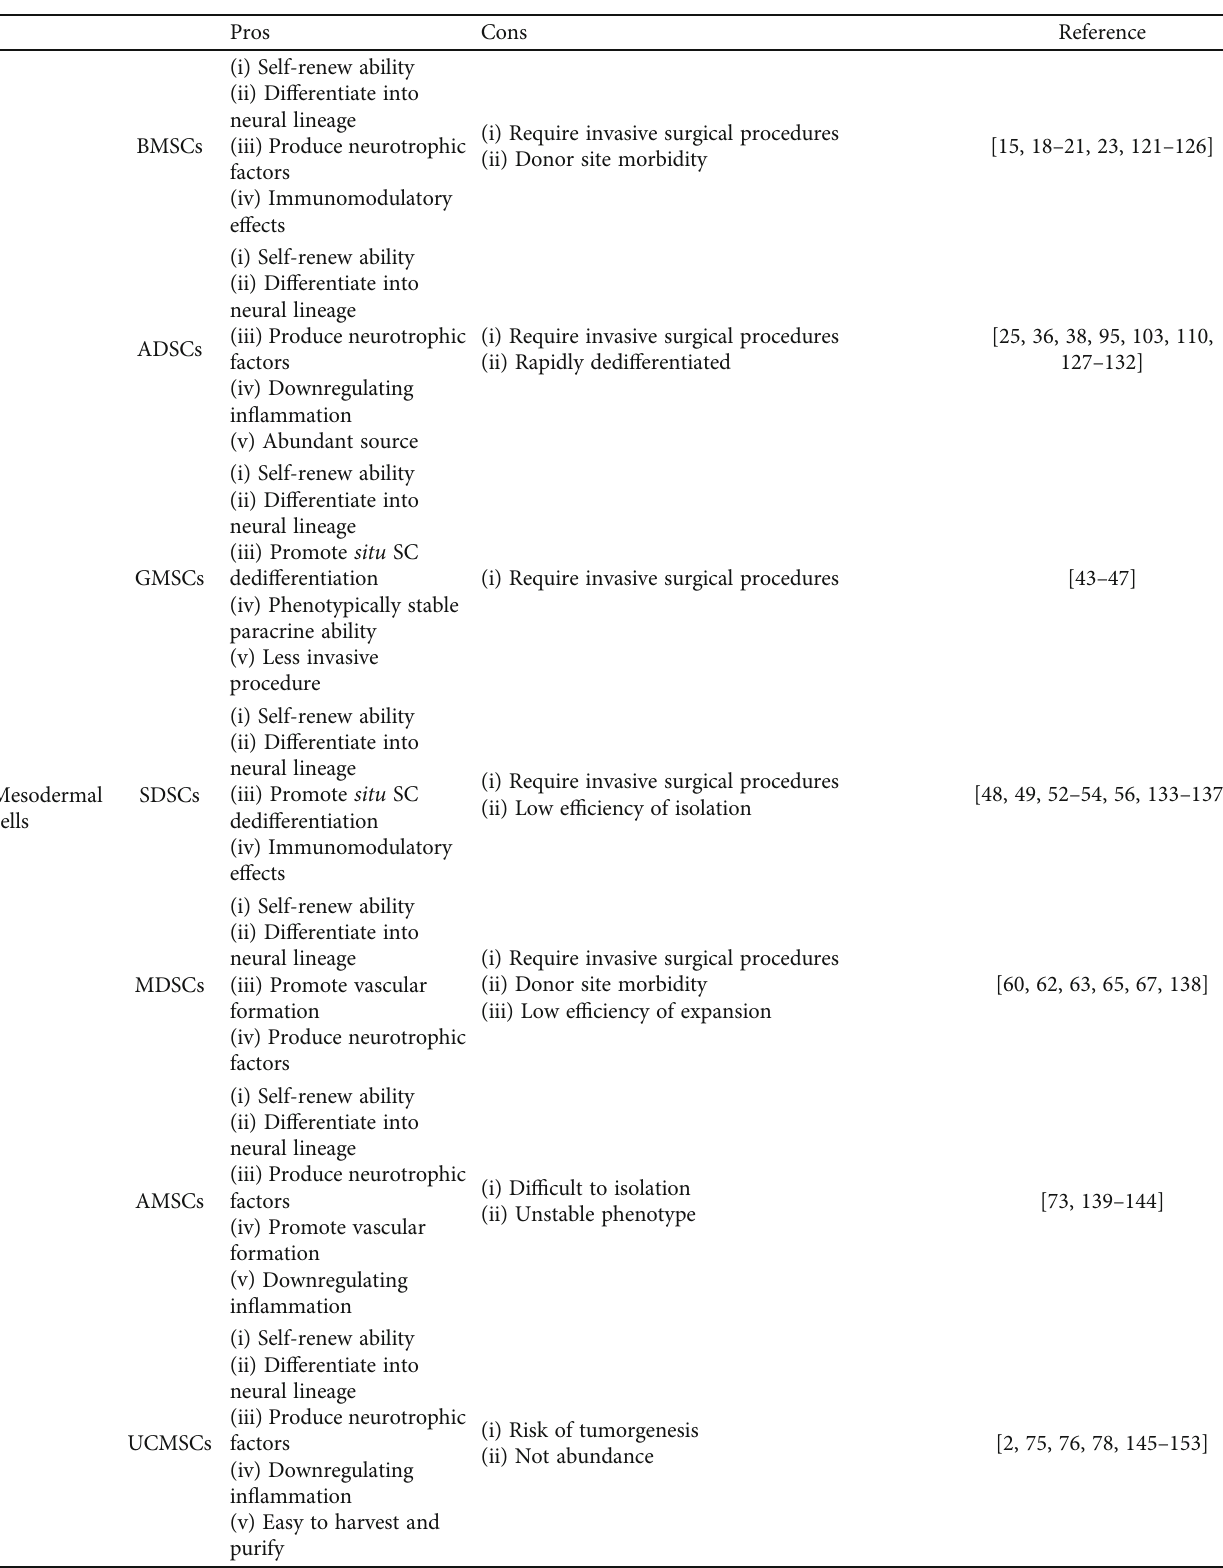
Table 5: Summary of pros and cons for stem